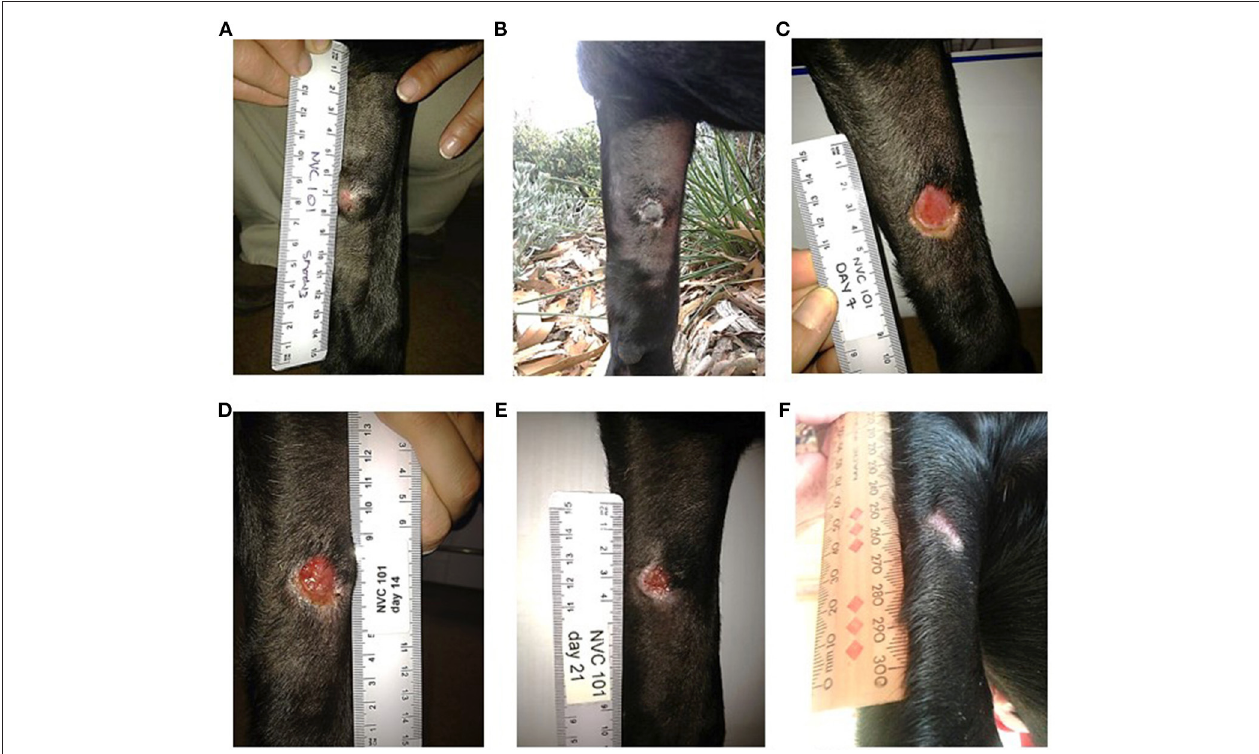
FIGURE 2 | Complete response following intratumoural injection of tigilanol tiglate. (A) MCT prior to treatment. (B) 24 hours post treatment. (C) 7 days post treatment. (D) 14 days post treatment. (E) 21 days post treatment. (F) 37 days post